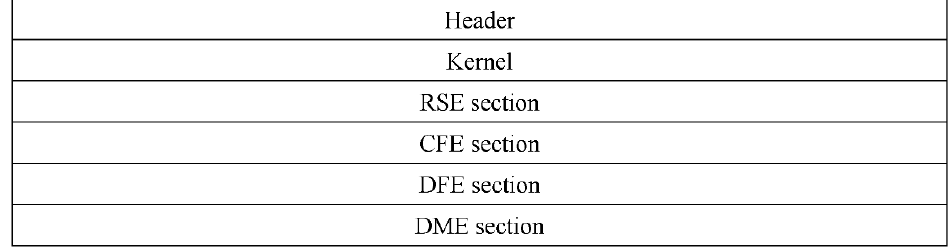
Figure 7. Generalized structure of a log file.